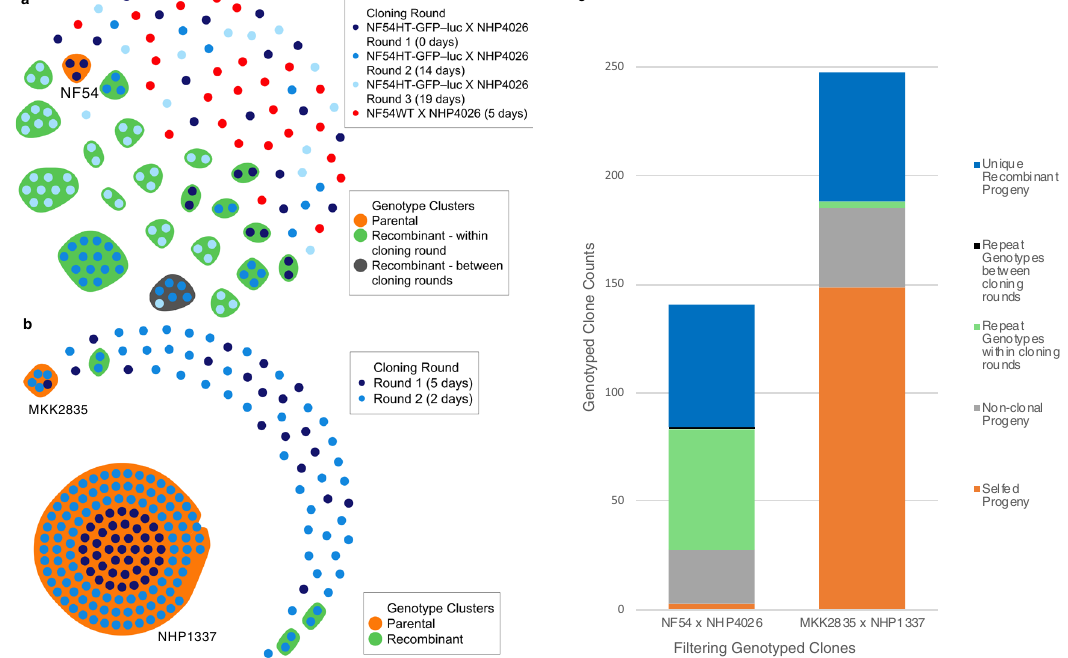
Fig. 2 Cloning results and recombinant progeny for each cross. a , b Genotyping results for each cross. Circles represent clonal genotyped progeny. Colored ellipses surround individual cloned progeny of the same genotype, with orange ellipses denoting parental progeny. a The cloned progeny from the NF54 × NHP4026 contained three selfed NF54 progeny (orange ellipse). The majority of repeat sampling of the same genotype (green and gray ellipse) occurred in cloning round 3, the gray ellipse denotes the only observed repeat sampling event between cloning rounds (rounds 2 and 3, gray ellipse). b The MKK2835× NHP1337 cross produced 144 selfed NHP1337 progeny, fi ve MKK2835 selfed progeny and few instances of repeat sampling (green ellipses). c Progeny were characterized to identify unique recombinant progeny (blue), selfed progeny (orange), non-clonal progeny (gray) and repeat sampling of the same genotype within a cloning round (green) and between cloning rounds